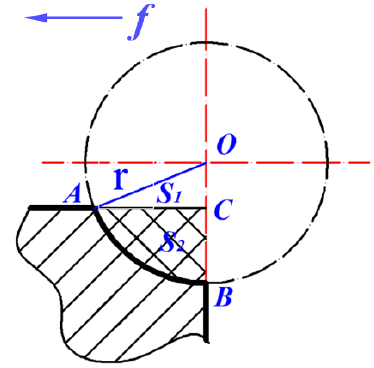
Figure 4. Geometric model of EDM grinding.